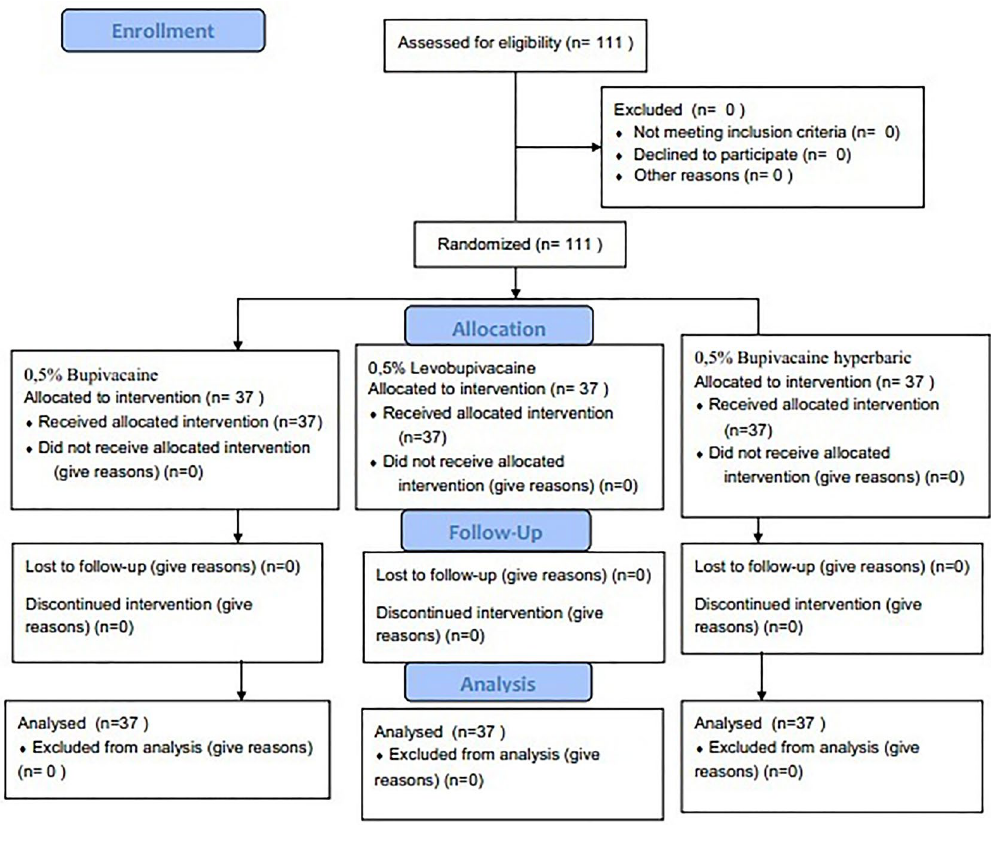
Figure 1. Flow chart on patient